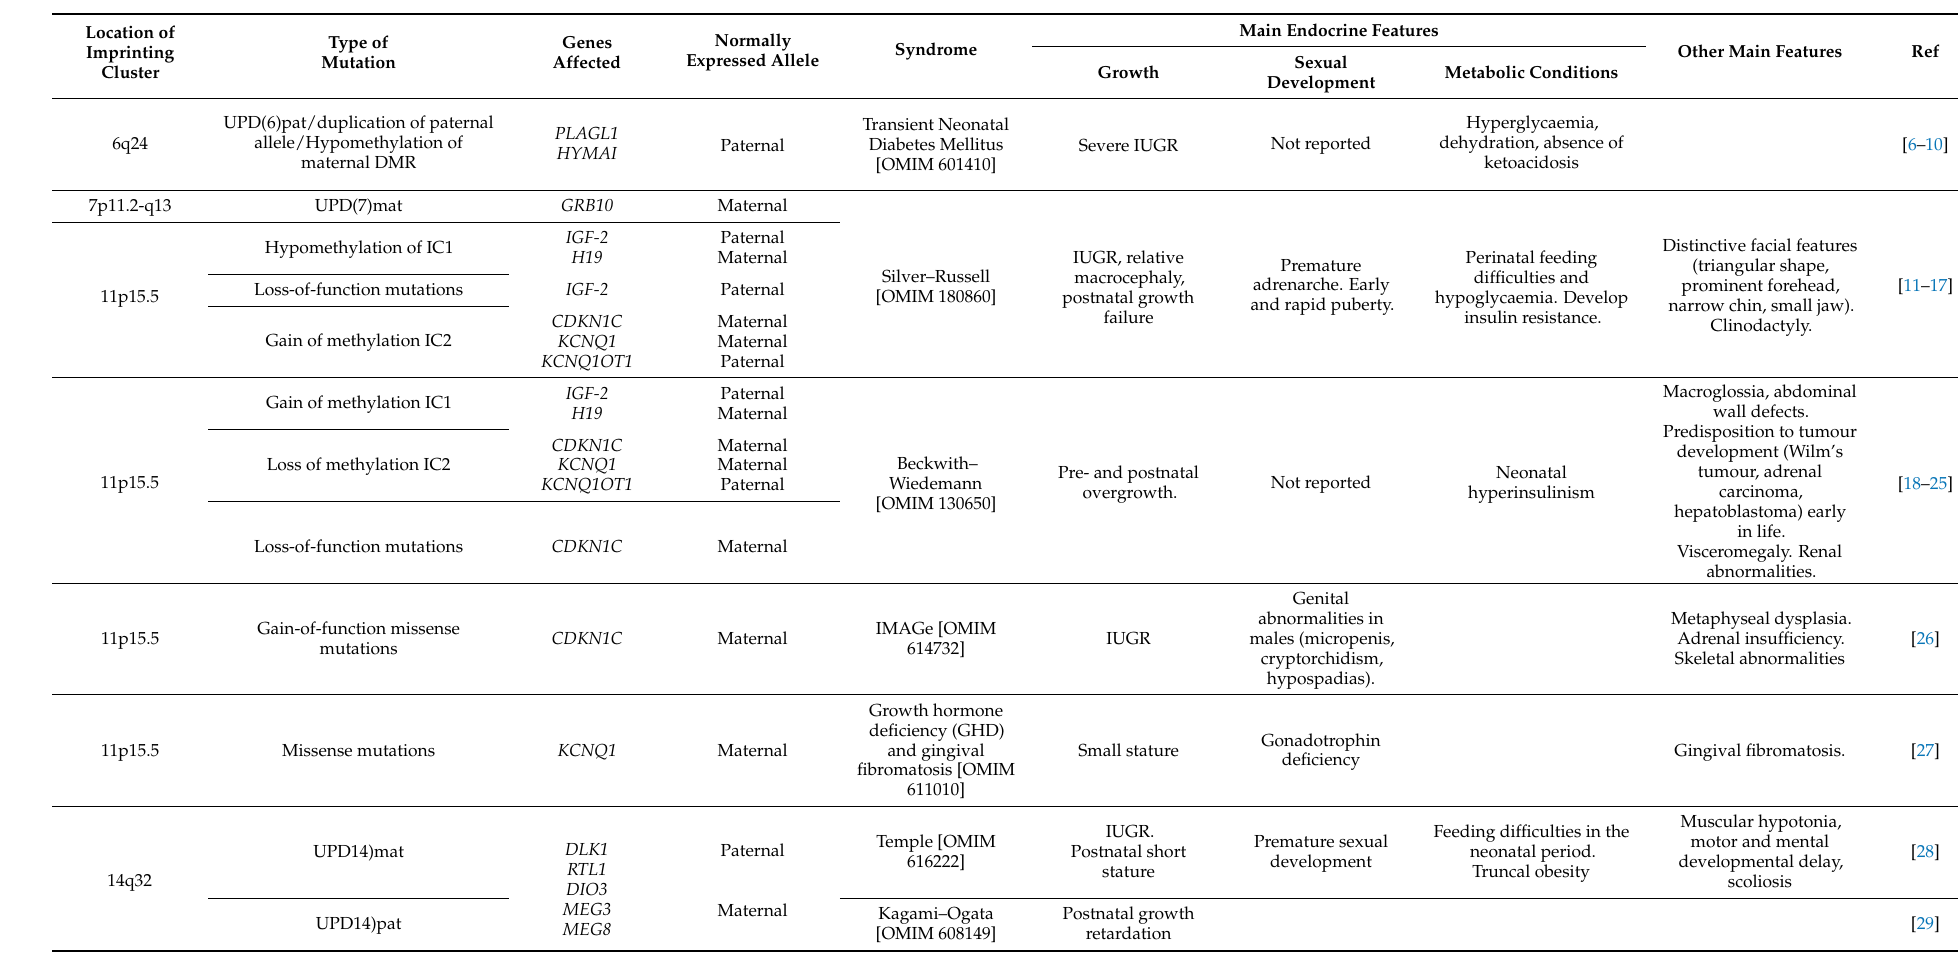
Table 1. Summary of human imprinting disorders highlighting endocrine/pituitary phenotypes. Imprinted genes tend to cluster into distinct chromosomal loci, and the genetic and epigenetic lesions associated with these loci are linked to disease phenotypes. The loss or gain of function of the same subset of imprinted genes can have distinct phenotypes, such